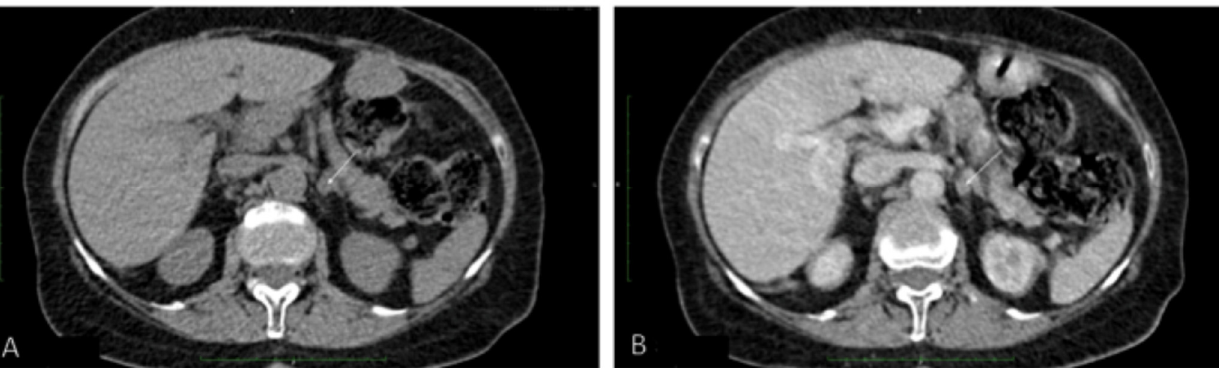
Figure 3. Abdominal computed tomography ( A ) without and ( B ) with contrast of a focal lesion in the left adrenal gland.